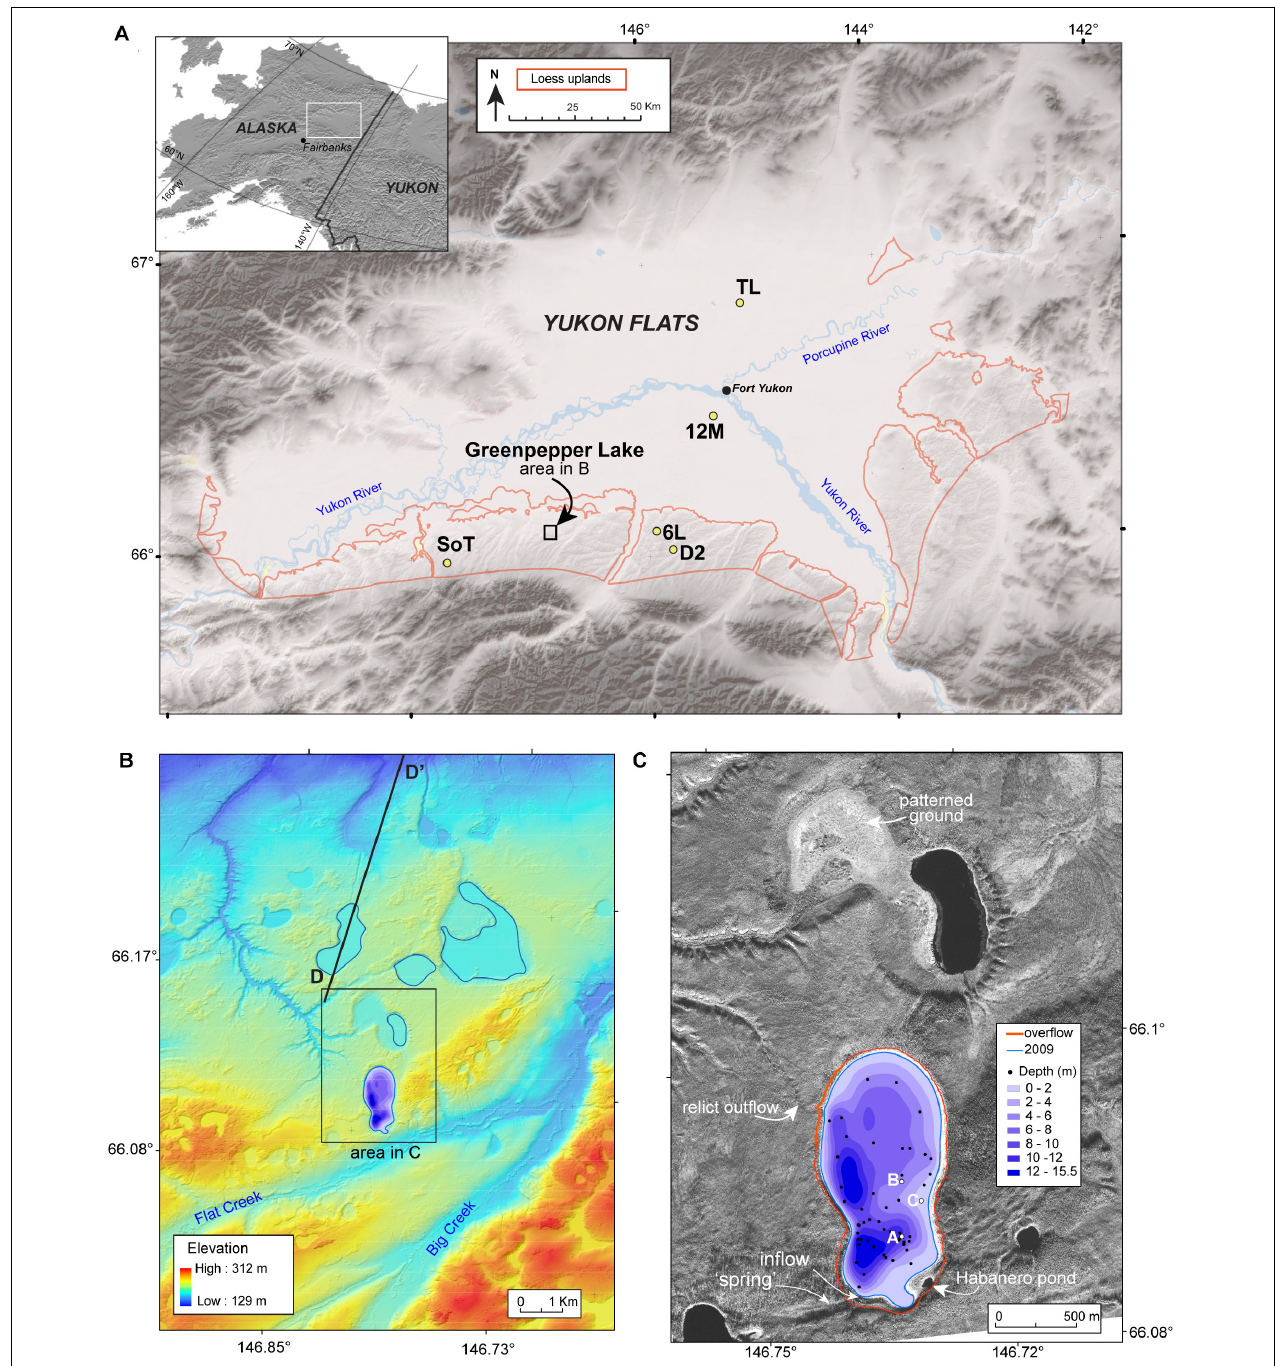
FIGURE 1 | Map of the Yukon Flats, Alaska study area: (A) . The southern loess uplands are enclosed by the red line: TL, Track Lake; 12M, Twelvemile Lake; SoT, Sands of Time Lake; 6L, Six Loon Lake; D2, Dune Two Lake. (B) Bathymetric contour map of Greenpepper Lake (purple shading) is shown on a 5-m IFSAR digital elevation model of the Flat and Big Creek areas. The electromagnetic survey line D-D’ from Minsley et al. (2012) indicates a deep talik underneath the lake to the north of Greenpepper; blue outlines of modern lake levels indicate the two partially filled basins. (C) Bathymetry (purple shading) on black imagery (Digital Globe WV02) in June of 2009, prior to the July 2009 fire, showing the locations of the sediment cores (A–C) , lake shorelines in 2009 (blue) and at the surface overflow elevation (red), and the ‘spring’ and inflow water sampling sites. Patterned ground is evident within the partially filled lake basin and the drainage channel intersects the same gully system as the raised relict outflow channel from Greenpepper